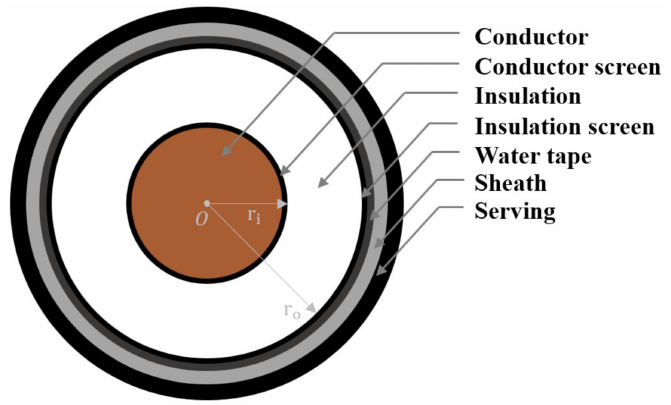
Figure 3. Structure of the extruded cable. Table 2. Structural dimensions according to cable insulation